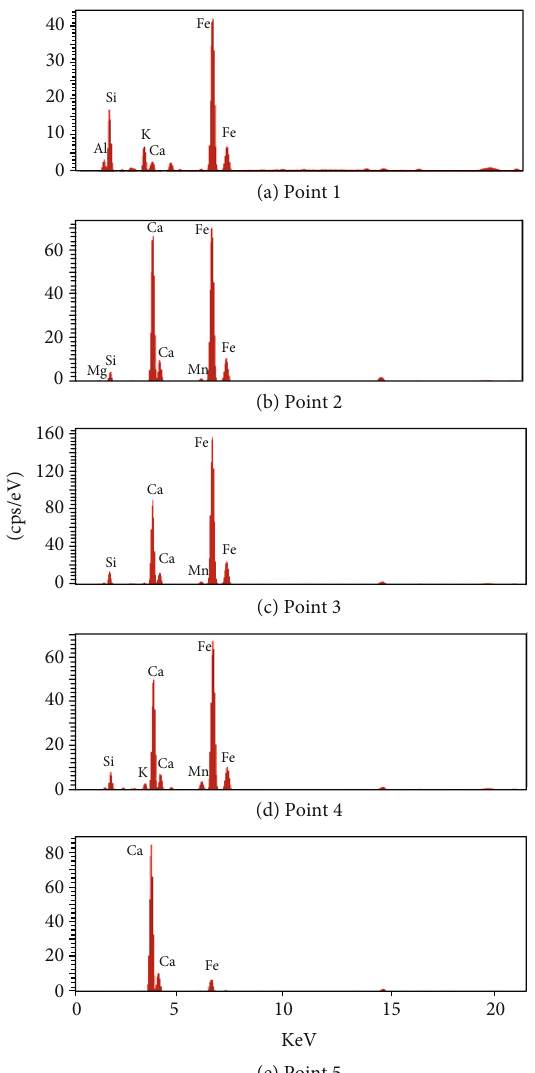
Figure 6: Representative XRF spectra of points 1-5 in Figure 1(d) with a 20 μ m diameter X-ray beam and a single-point exposure time of 10s (point 1: black shale; point 2: dolomite; point 3: ankerite; point 4: manganese-ankerite; point 5: limestone